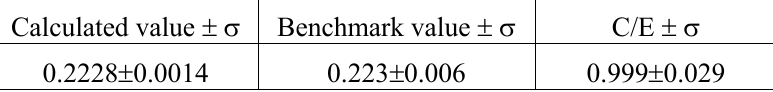
Figure 9 . Effect of 235 U Mass on Reactivity. Table I. Reactivity equivalent of 235 U additions, ( dr )/( d